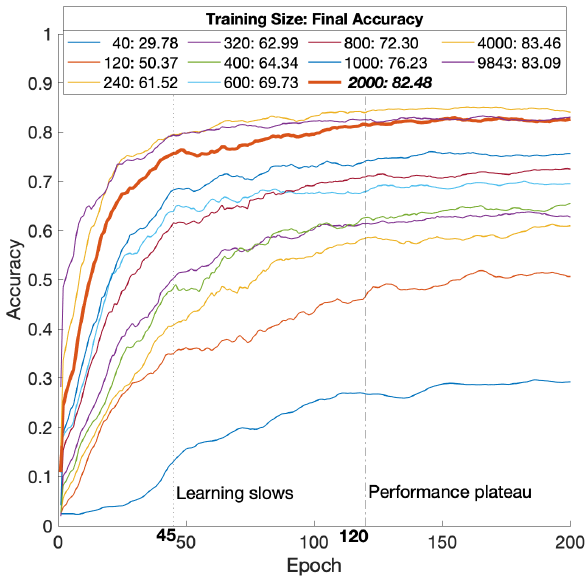
Figure 6. PointNet moving mean accuracy versus